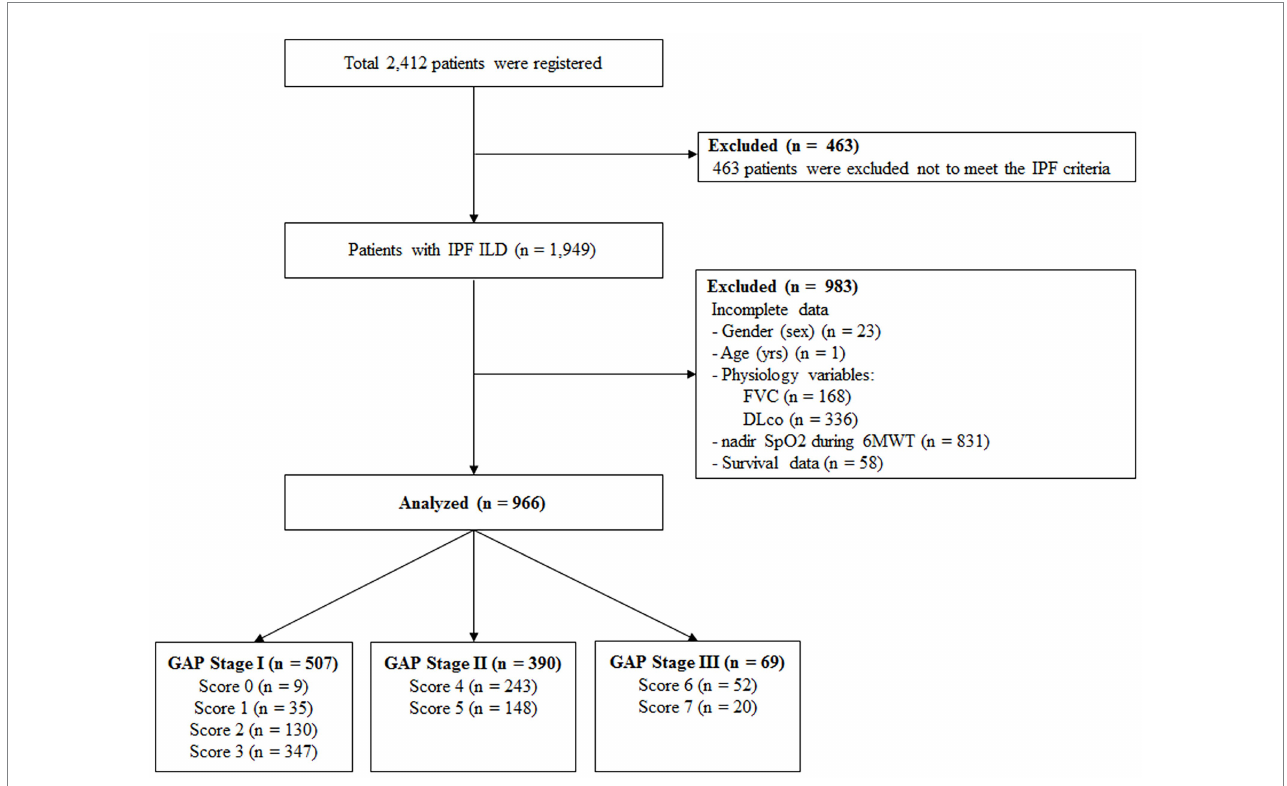
FIGURE 1 Overview of study design IPF, idiopathic pulmonary fibrosis; ILD, interstitial lung disease; FVC, functional vital capacity; DLco, diffusing capacity of the lung for carbon monoxide; SpO2, saturation of percutaneous oxygen; 6MWT, six-minute walk test; GAP, gender, age, and